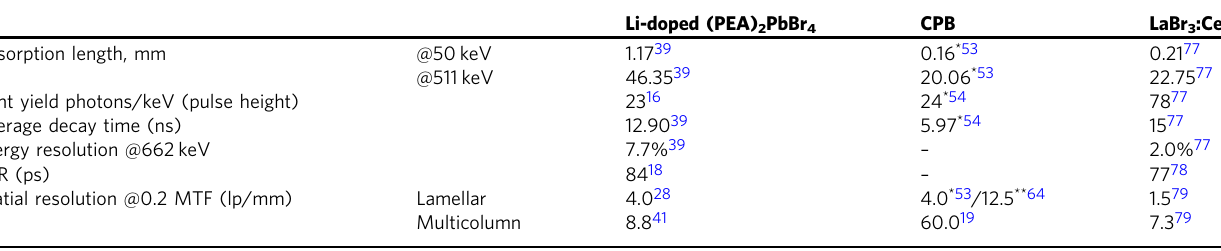
Table 1 Fast ( ≤ 15 ns) and high light yield (>20 photons/keV) perovskite scintillators versus LaBr 3 :Ce. Li-doped (PEA) 2 PbBr 4 CPB LaBr 3 :Ce